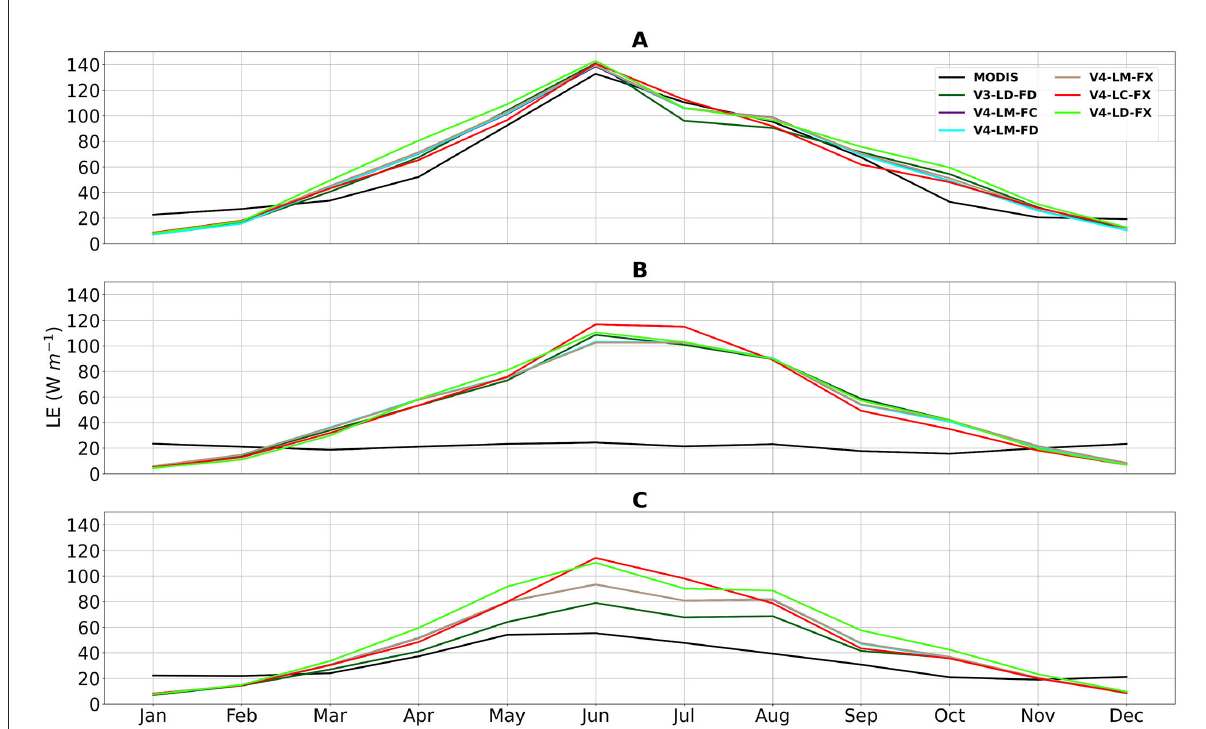
FIGURE8 Climatological LE from all different Noah-MP configurations vs. MODIS across the selected domain for the entire study period (2008–2018) for (A) grid cell with the highest KGE value (0.90) located in the western part of the state and the dominant land cover type is classified as grassland, (B) grid cell with minimum KGE threshold ( 11.87) located in the eastern part of the state and the dominant land cover type is classified as − cropland/grassland mosaic, (C) grid cell with minimum threshold KGE value ( 0.42) located in the south-central region of the state and the − dominant land cover type is classified as grassland. Here, colors represent different models consistent with the color